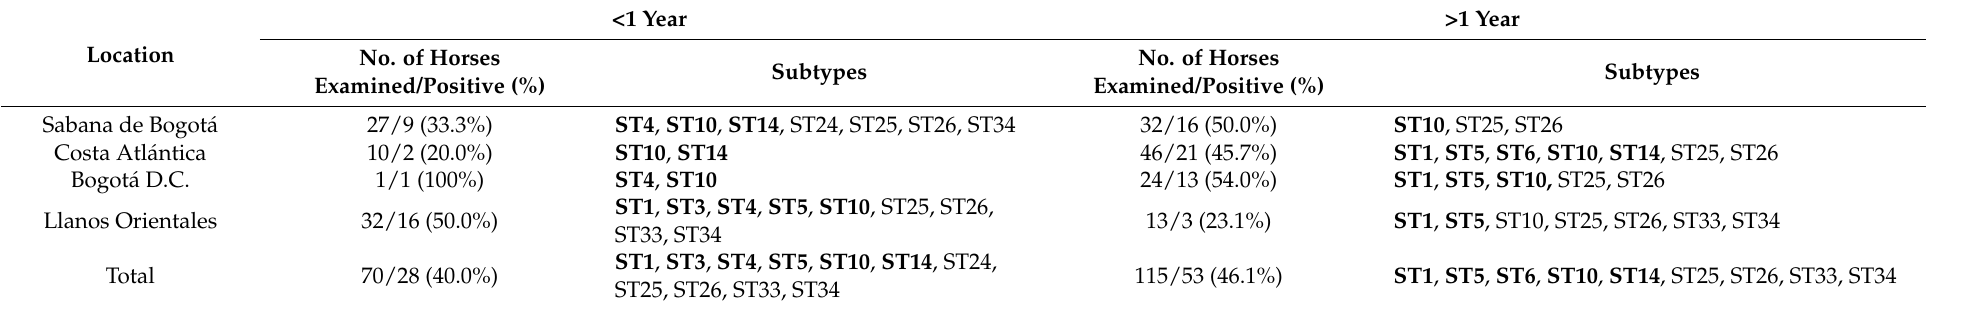
Table 3. Number of horses examined, number of horses positive, prevalence (%), and subtypes of Blastocystis by age at each location. Subtypes in bold denote those previously identified in humans.